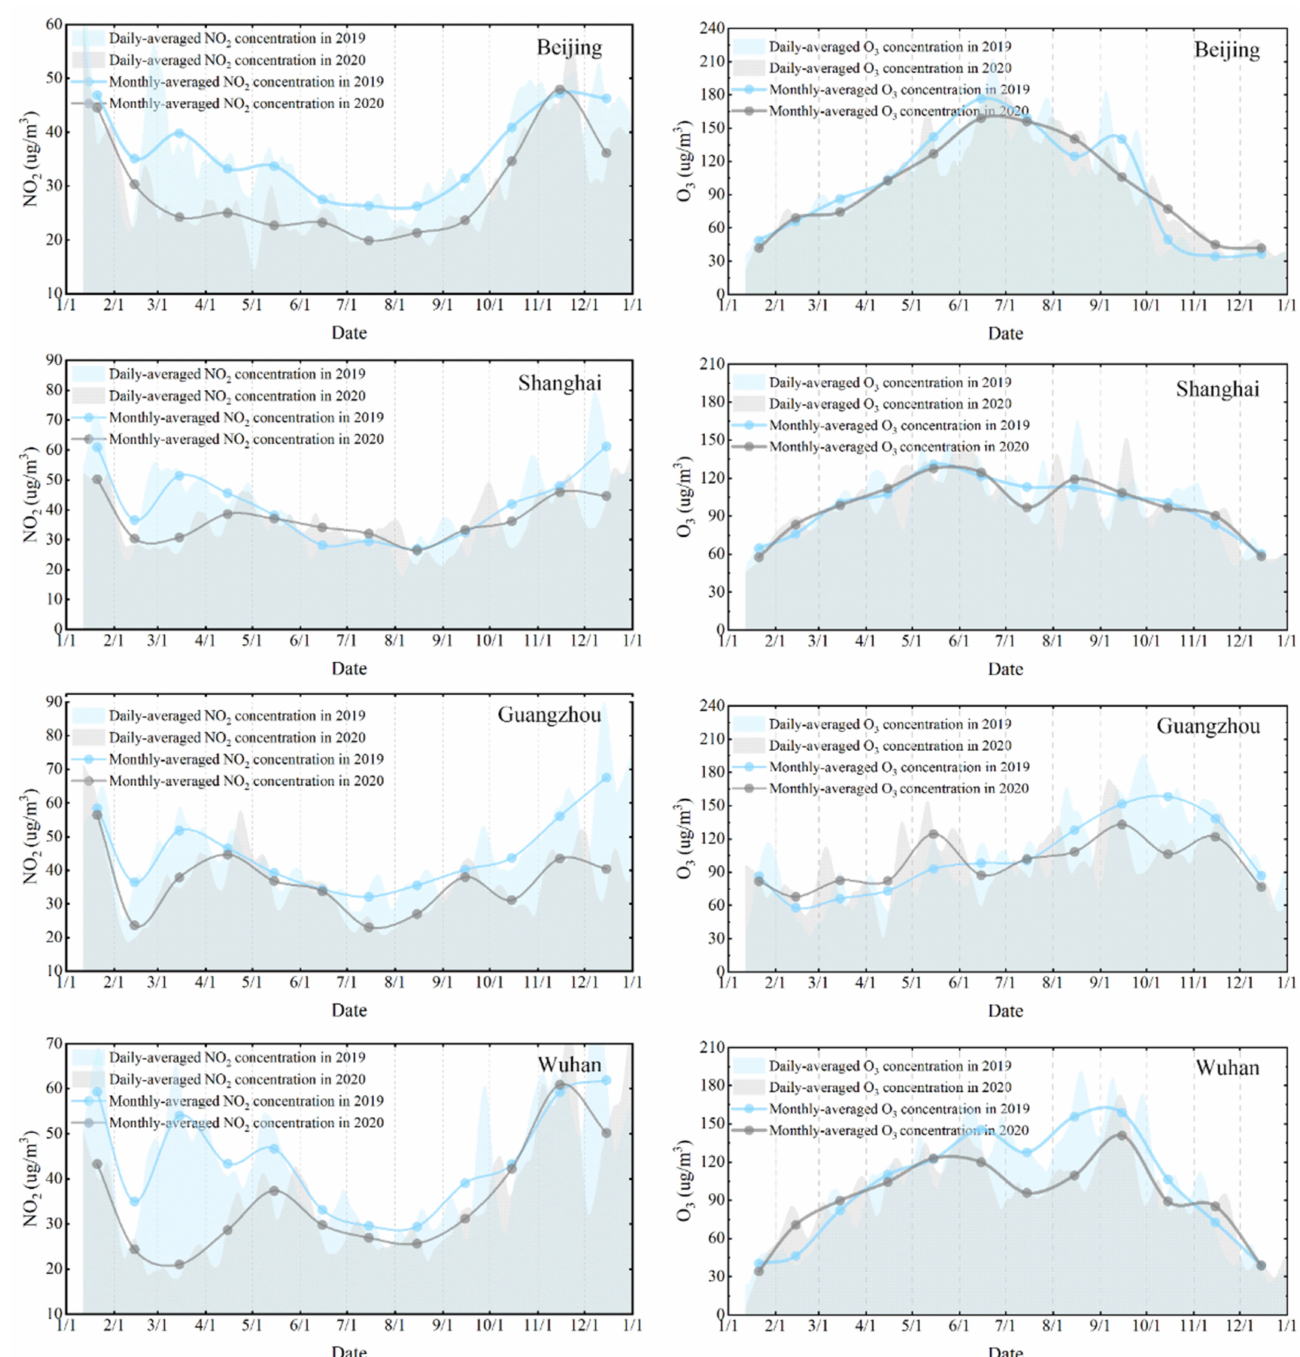
Figure 7. Daily averaged and monthly averaged concentration changes in NO 2 and O 3 in 2019 and 2020. The blue and gray areas in the figure represent the daily averaged concentrations of NO 2 and O 3 in 2019 and 2020, respectively. The blue and gray curve represents the monthly averaged concentrations in NO 2 and O 3 in 2019 and 2020, respectively. We matched the data for 2019 and 2020 according to the Chinese New Year, and the time series in the figure is from 12 January to 31